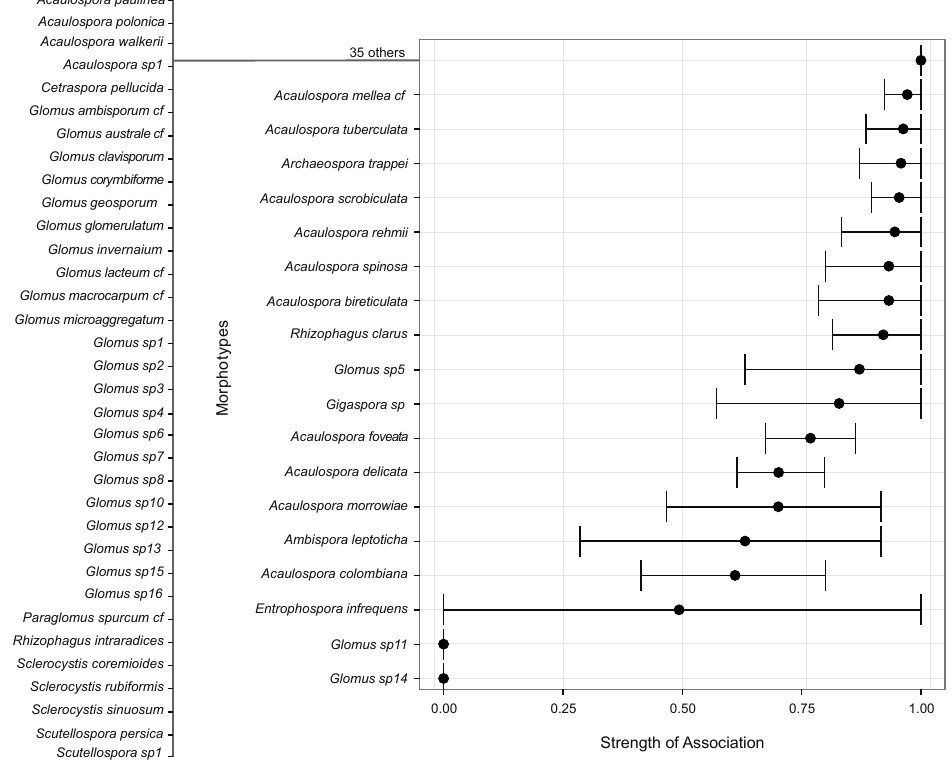
Figure 3 – Strength of association between occurrence of morphotypes from fi eld samples as revealed by the “A” component of the indicator value index, varying from 0 to 1.0. The value 0 indicates no occurrence of morphotypes in fi eld samples while 1.0 indicates exclusive occurrence in that method. Fourteen rare morphotypes (occurring in less than two samples out of 98 samples) were not considered.